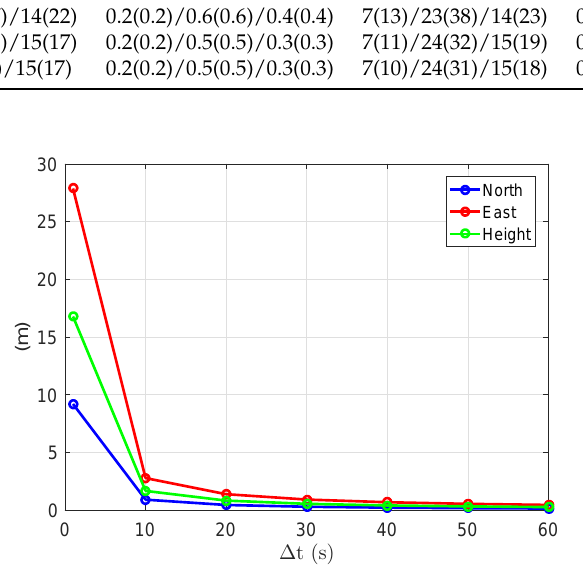
Figure 12. Average formal standard deviations of the baseline errors in the ambiguity-float case. GPS triple-frequency phase data of baseline CUAA-CUBB was used for the